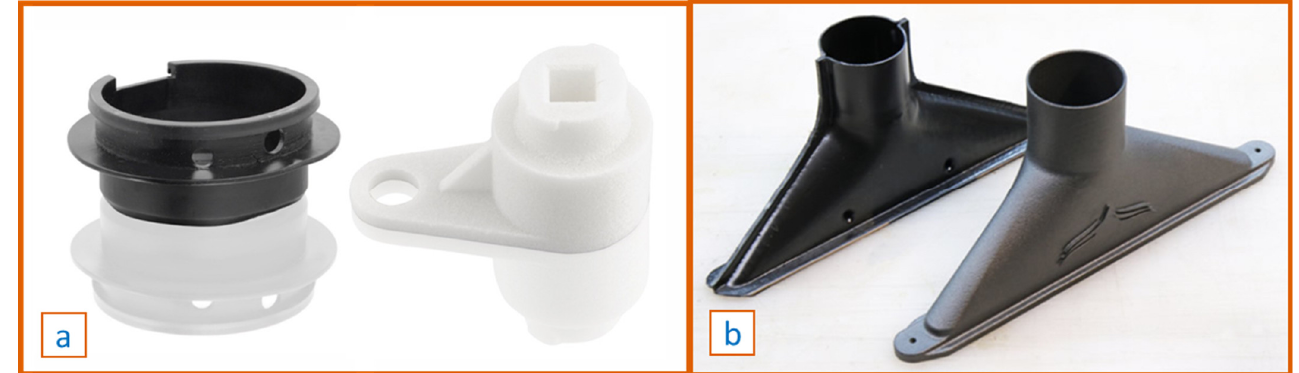
Figure 3. Polymer spare-part reconstruction based on direct AM processes: ( a ) Porsche 964 crank arm and Porsche 959 filler-cap seal (photo credits: Porsche Classic 3D printing, 2018, Porsche AG). ( b ) Jaguar E-Type heating air ducts (photo credits: Eagle/HP ) .